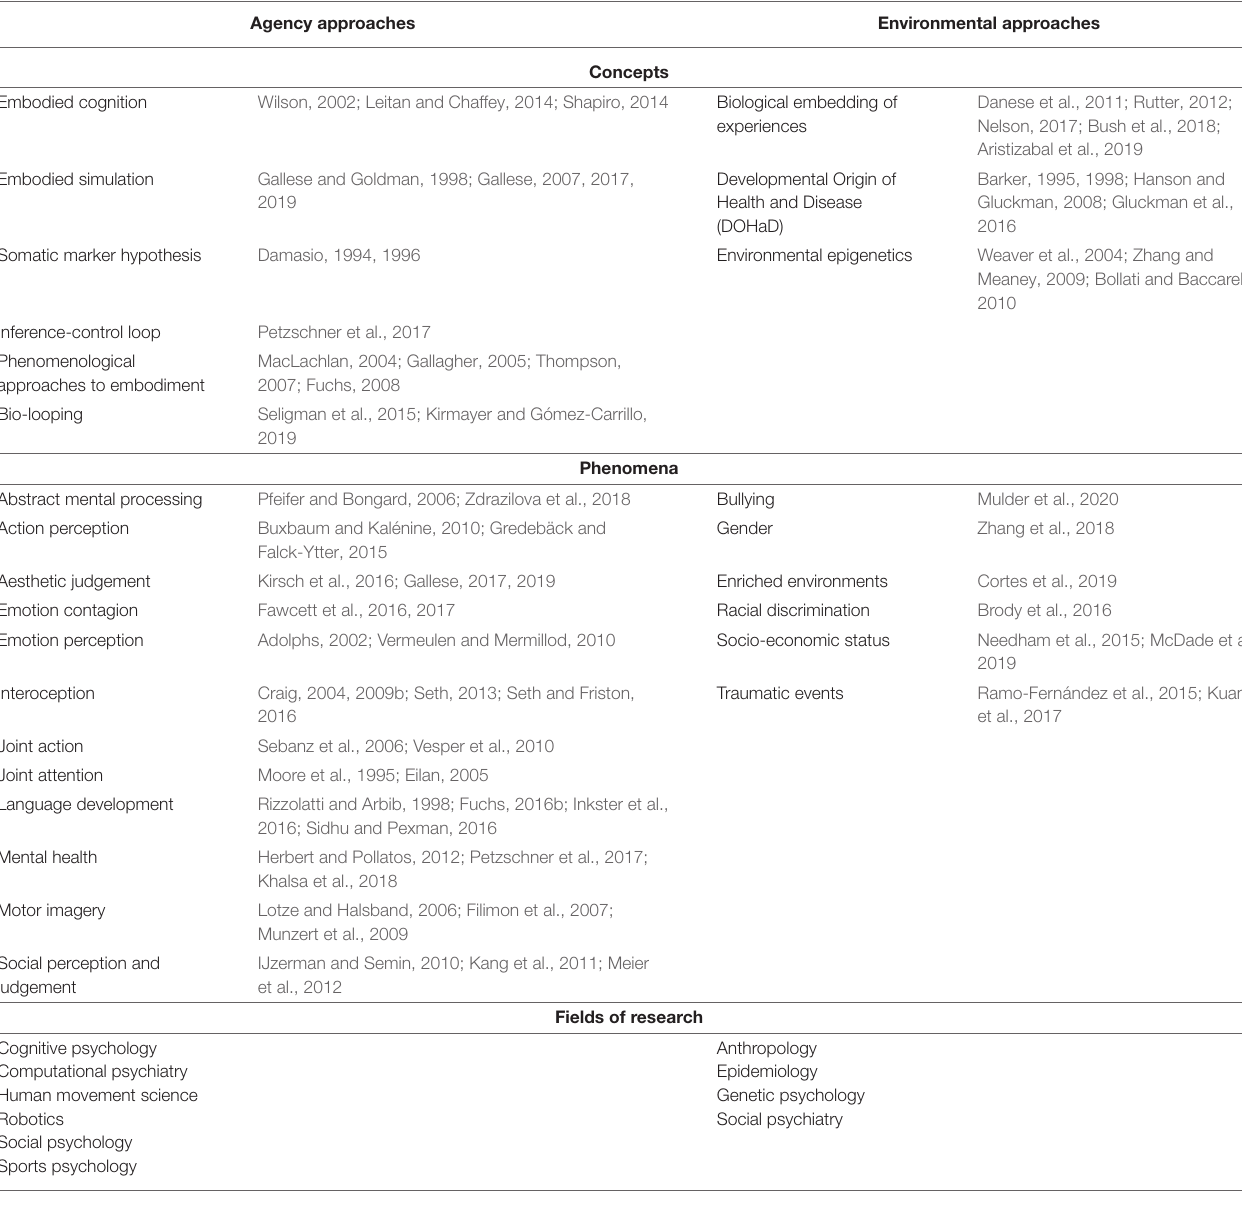
TABLE 1 | Examples of agency and environmental approaches to embodiment: concepts, phenomena and fields of